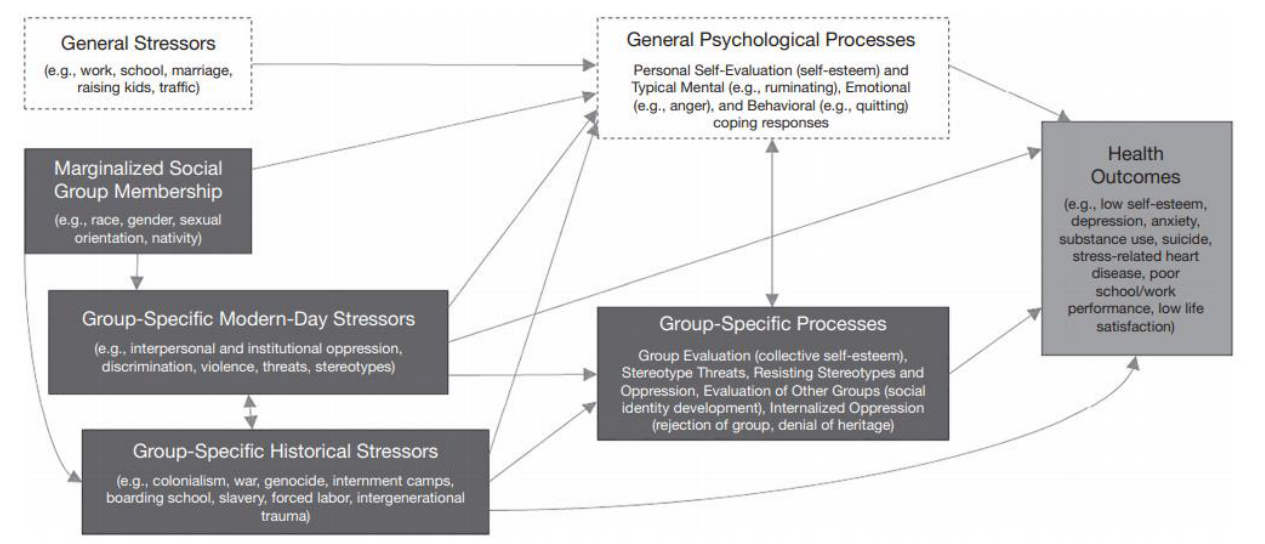
Figure 1: The potential consequences of oppression on marginalized peoples (David and Derthick, 2017) Discrimination against a white person as “sour milk” does not promote tension or alteration of power or